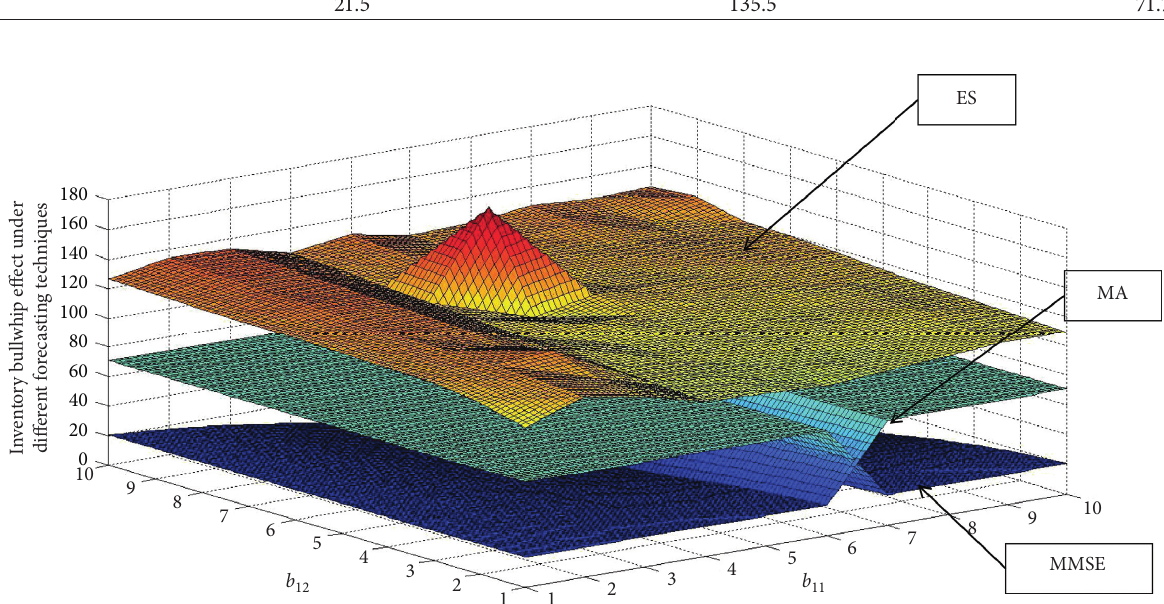
Figure 11: The impact of b